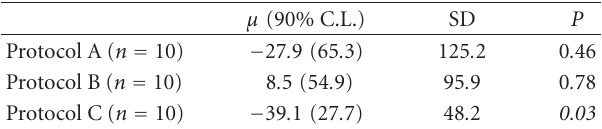
Table 3: Comparison of statistics for c 3 among decellularization protocols. Italics indicate statistical significance ( P < . 05). Values